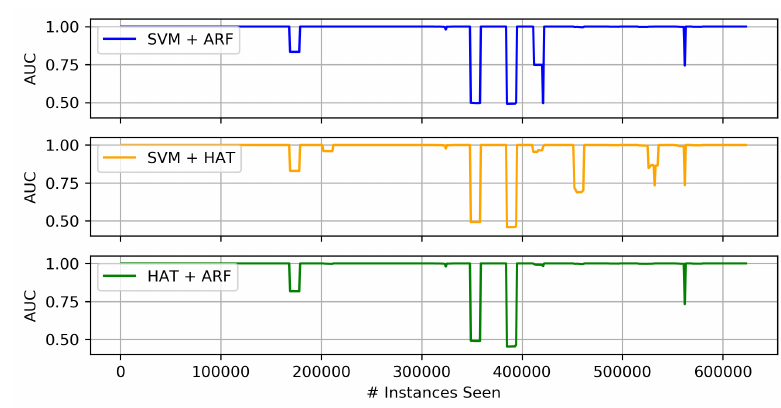
Figure 2. Comparison of heterogeneous ensemble performances on the HTTP data subset.